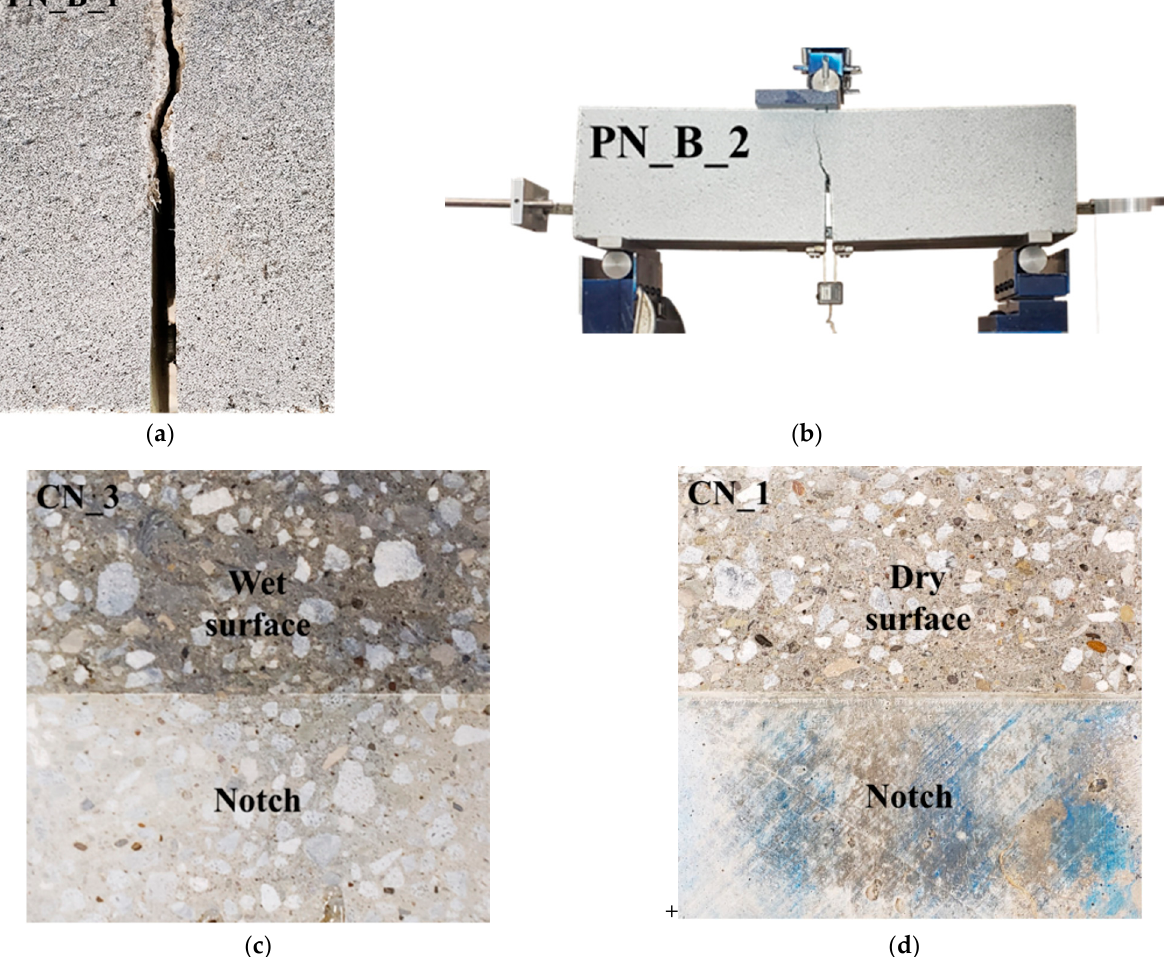
Figure 10. ( a ) Tortuous crack path of PN_B_1; ( b ) Picture of the PN_B_2 specimen just before the test was stopped; ( c ) Wet fracture surface of CN_3; ( d ) Dry fracture surface of CN_1.